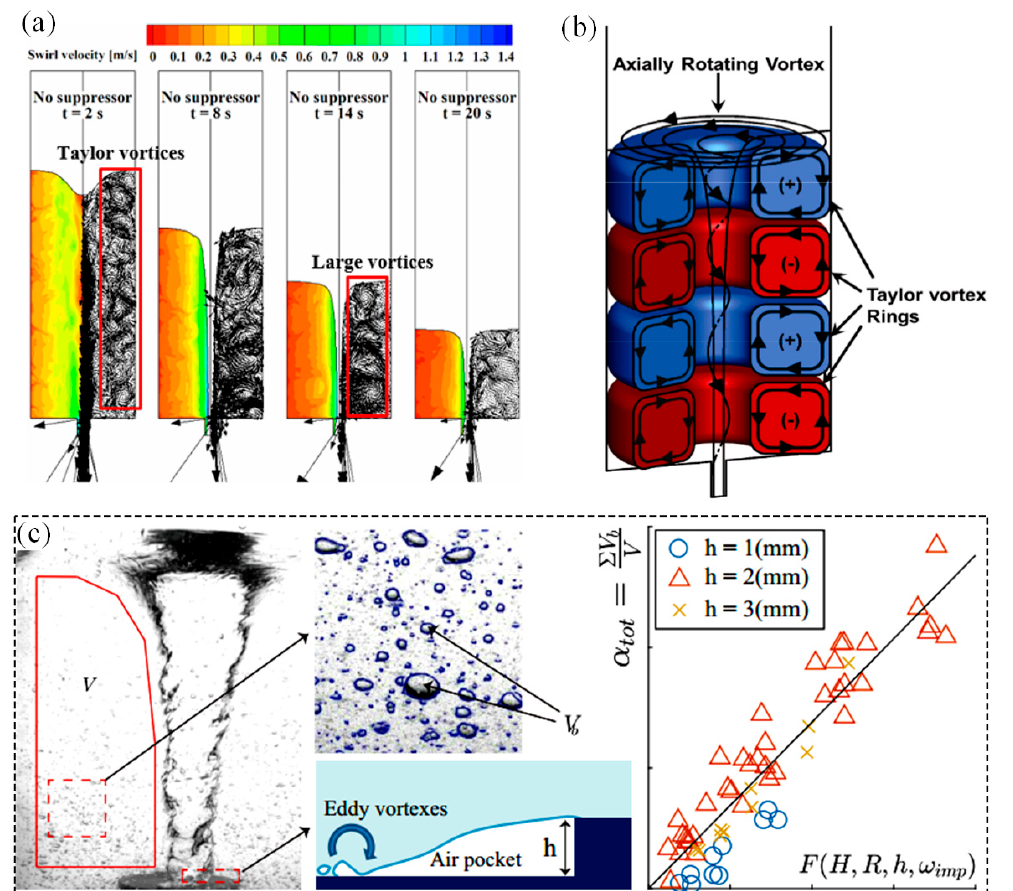
Figure 3. Turbulence structures evolution of vortex flow fields [55,56,58]. ( a ) Distributions of swirl velocity. (Reprinted with permission from Ref. [55]. 2018, Springer Nature). ( b ) Schematic image of the vortex interaction. (Reprinted with permission from Ref. [56]. 2011, Elsevier). ( c ) Total void fraction. (Reprinted with permission from Ref. [58]. 2021, Elsevier).